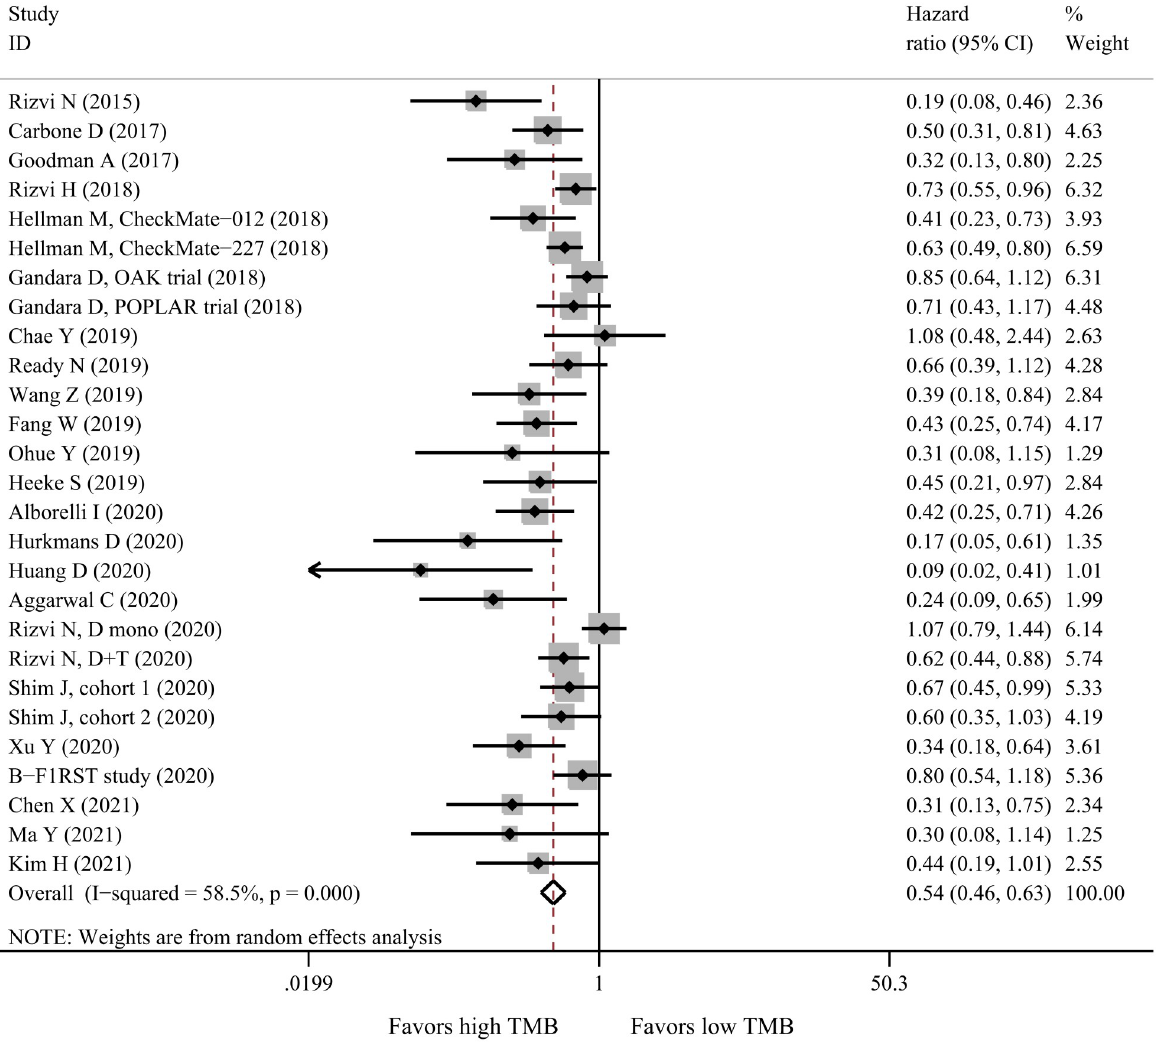
Fig 2. Forest plot for PFS of high-TMB versus low-TMB in NSCLC patients receiving immunotherapy. PFS: Progression-free survival; TMB: Tumor mutational burden; NSCLC: Non-small cell lung